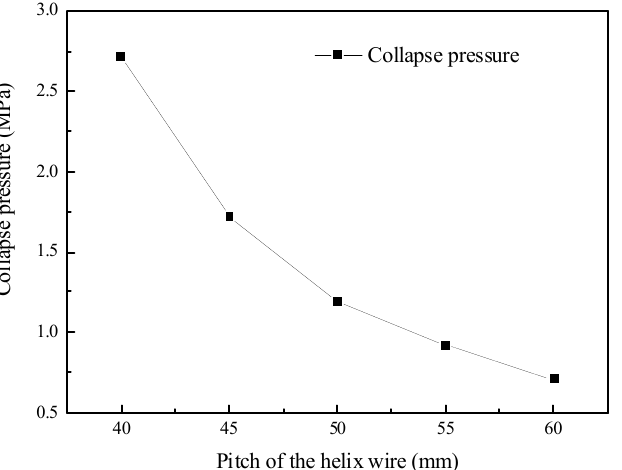
Figure 17. Collapse pressure of submarine hose corresponding to various pitches of helix wire.